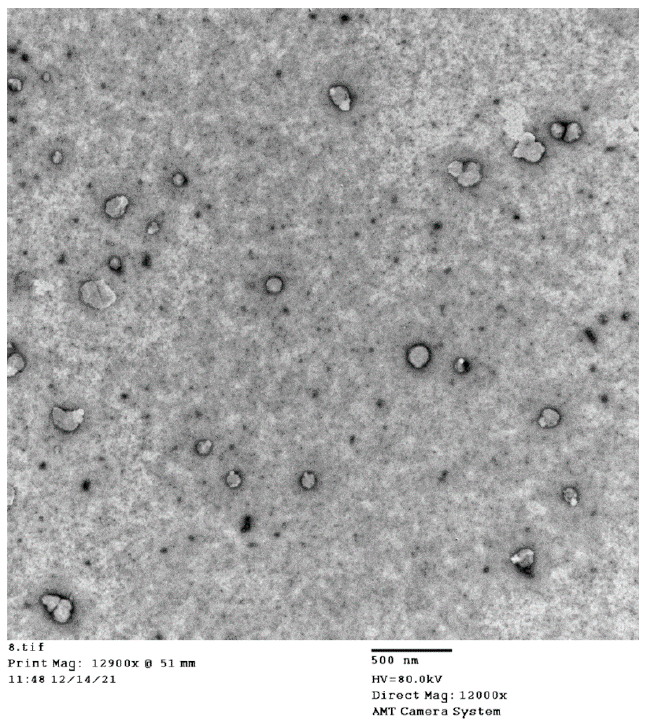
Figure 8. TEM images of the optimized ICA–tocozeinolate nanosphere formula.